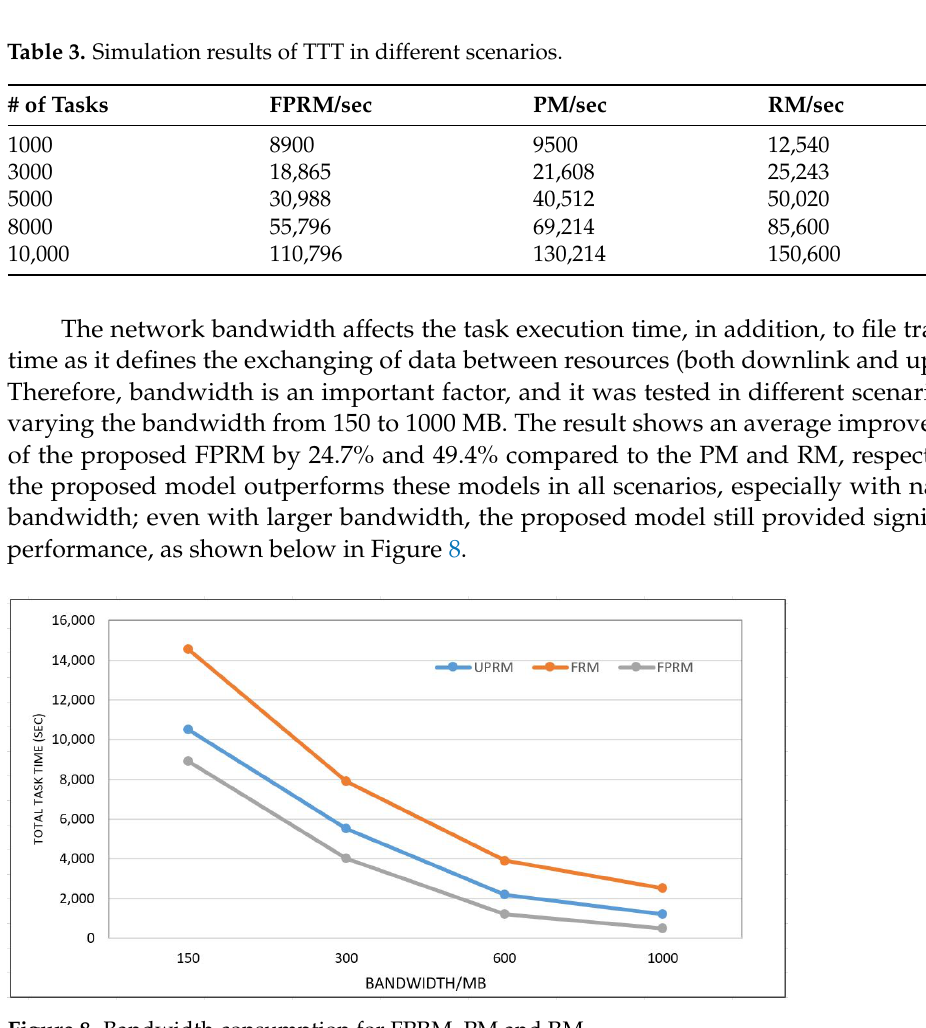
Figure 8. Bandwidth consumption for FPRM, PM and RM.